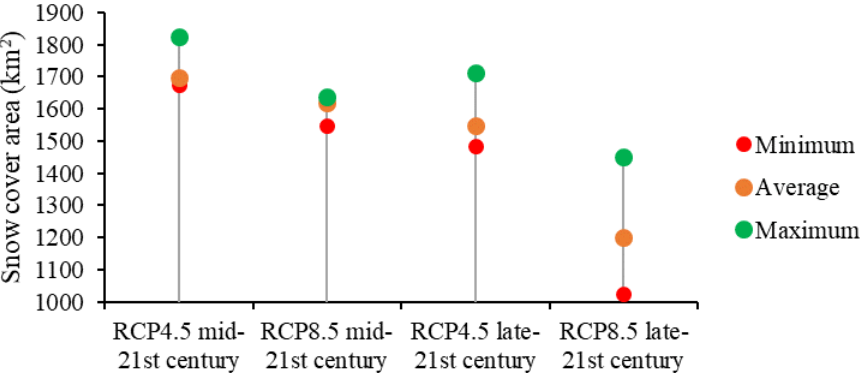
Figure 8. Comparison of the minimum, maximum, and average SCAs projected under RCP 4.5 and 8.5 during the mid- and late 21st century.